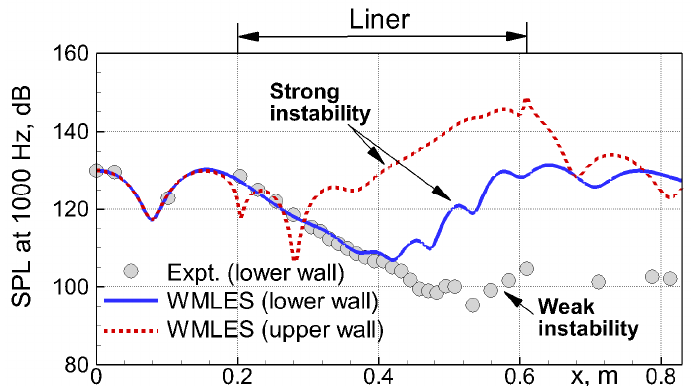
Figure 3. Measured in [14] and predicted by WMLES [13] distributions of sound pressure level along upper (with the liner) and lower (opposite to the liner) walls of NASA GIT at f e = 1000 Hz.